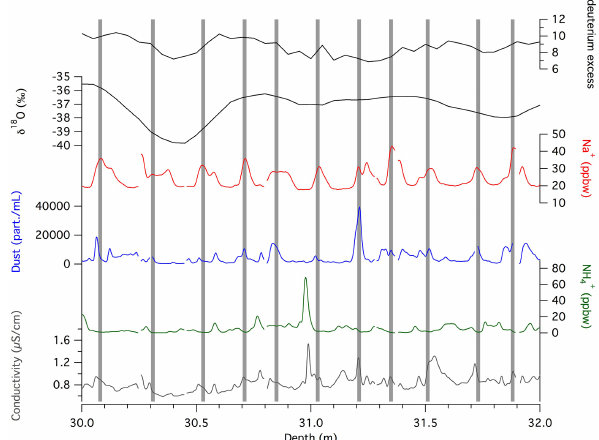
Figure 5. Stable water isotopologues and chemical impurities deter- mined in the NEGIS firn core between 30 and 32m depths. Vertical grey bars indicate assignment of annual layers, corresponding ap- proximately to mid-winter (i.e. 1 January) of each year. δ 18 O and deuterium excess were determined in discretely cut ice sampled at 5cm resolution while the impurities were determined from contin- uous flow analysis measurements. The δ 18 O and deuterium excess have been heavily diffused at this depth and no longer allow annual layer